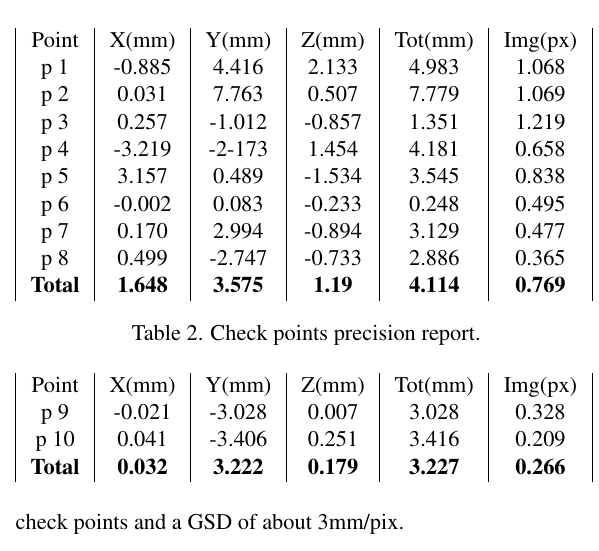
Table 1. Control Points precision report.